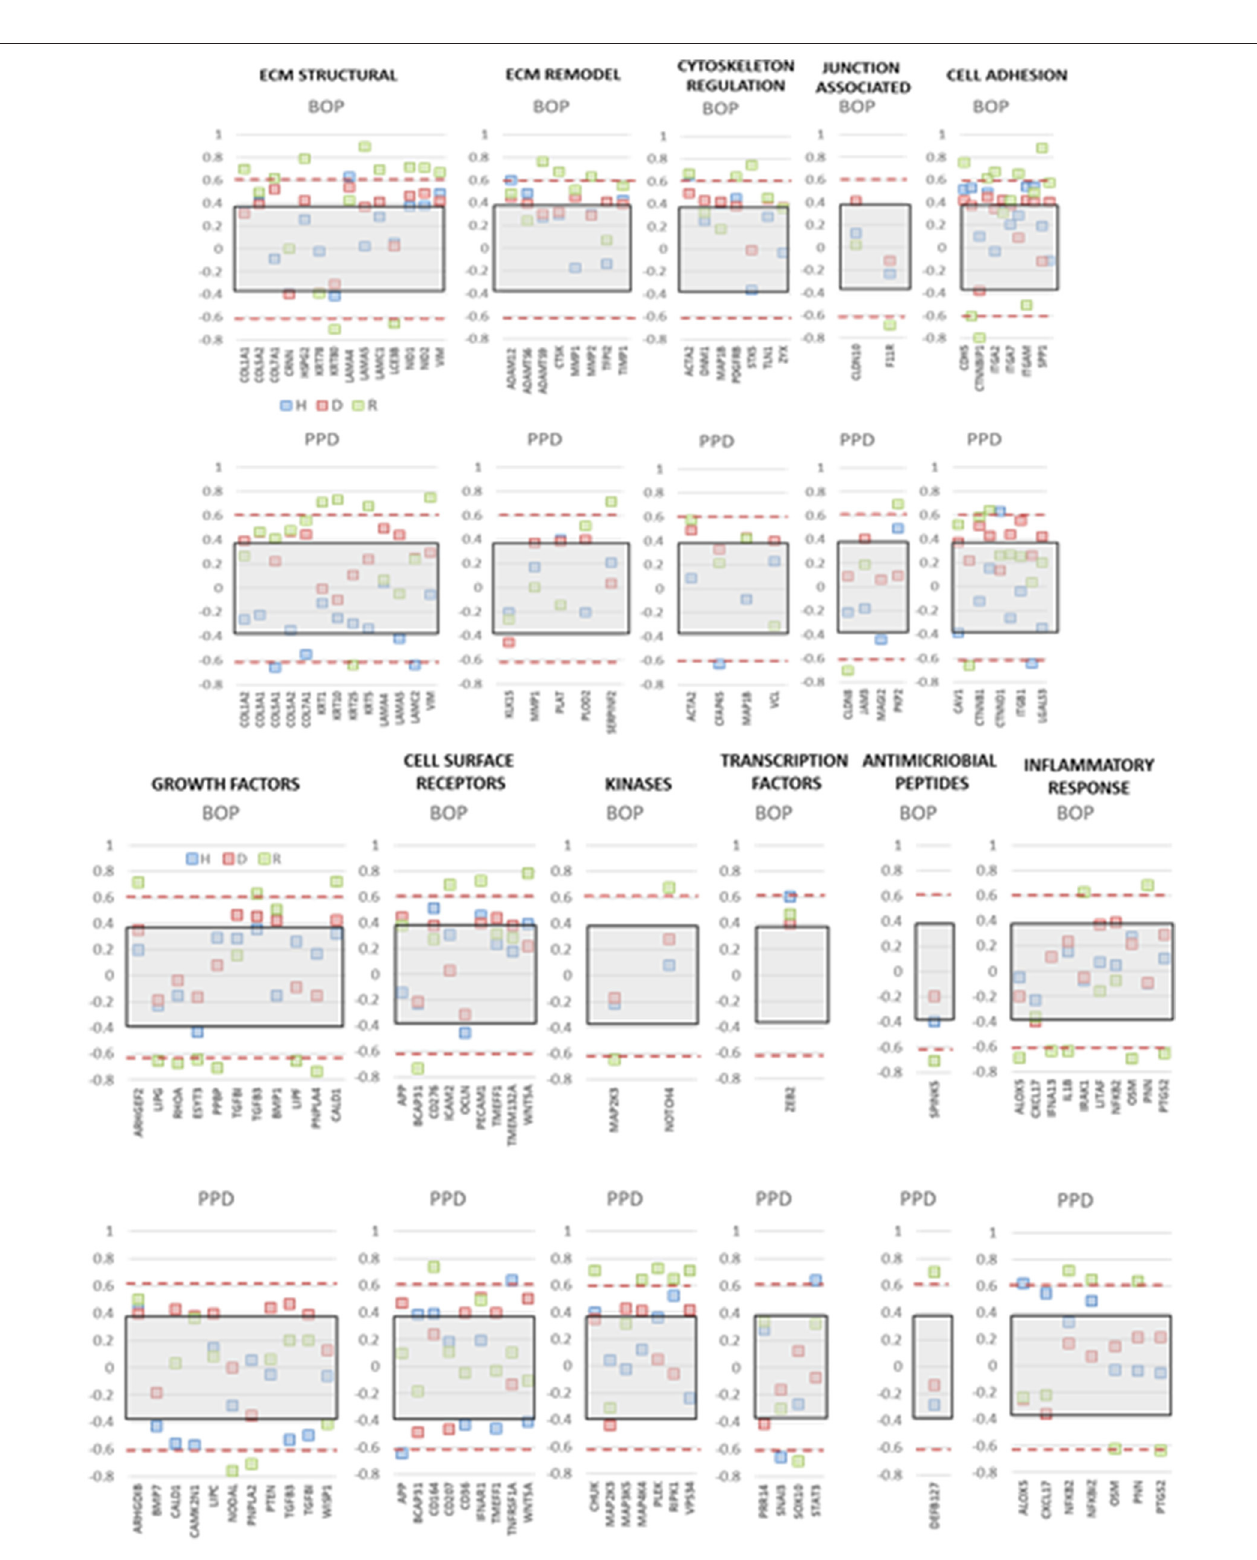
FIGURE 7 | Correlation analysis of gene expression levels in adult and aged animals with clinical parameters of mean bleeding on probing (BOP) and mean probing pocket depth (PPD). The red dashed lines denote significance level of the correlation coefficient at p < 0.01 for the health (baseline ) and resolution ( ) samples. The gray shaded rectangle denotes the significance level of the correlation coefficient at p < 0.01 for the pooled disease ( ) sample data.